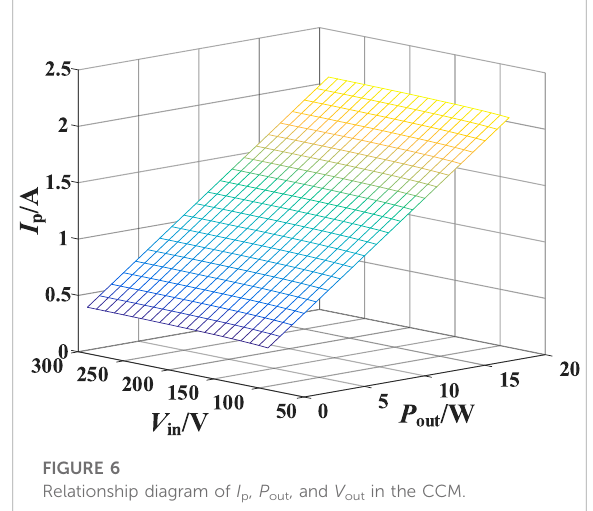
FIGURE 6 Relationship diagram of I p , P out , and V out in the